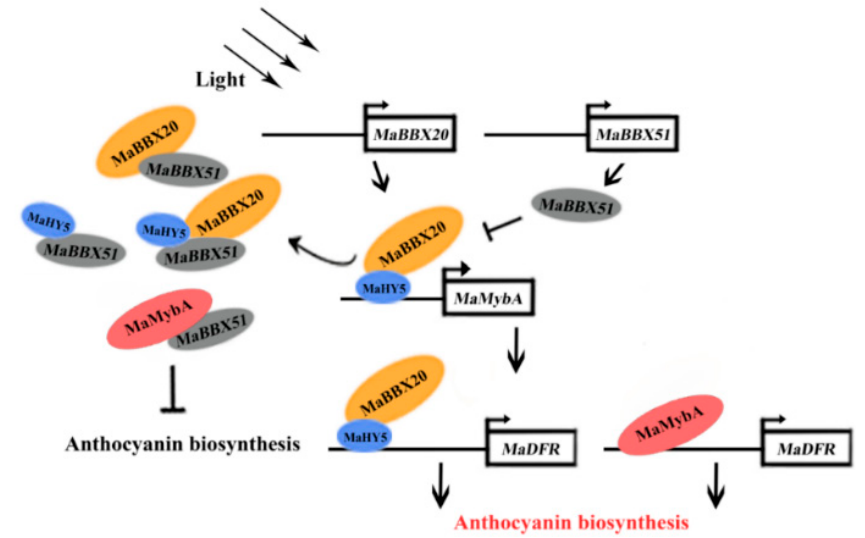
Figure 8. Suggested model for the roles of MaBBX20 and MaBBX51 in light-induced anthocyanin biosynthesis in grape hyacinth. Light activates MaBBX20, MaBBX51, and MaHY5 expression. MaBBX20 then interacts with MaHY5 and forms a MaBBX20–MaHY5 complex to activate MaMybA and MaDFR transcription, thereby positively regulating anthocyanin biosynthesis. Conversely, MaBBX51 interacts with MaHY5 and MaBBX20, hampering the formation of the MaBBX20–MaHY5 complex and subsequently inhibiting MaMybA and MaDFR transcription. MaBBX51 can also interact with MaMybA, inhibiting its binding to its promoter or that of MaDFR, thereby negatively regulating anthocyanin